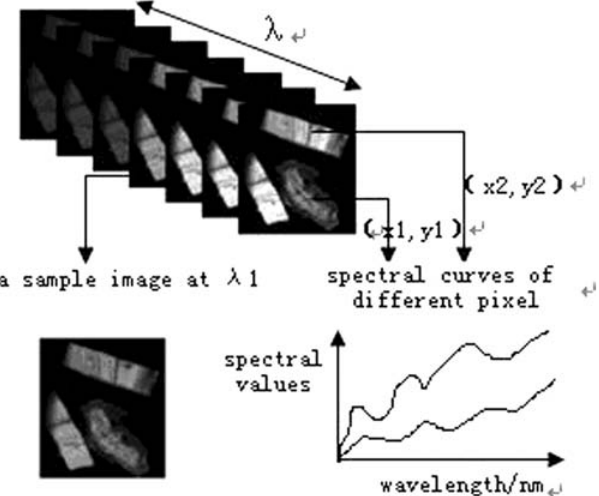
Fig. 2. Hyperspectral image block of a sample.